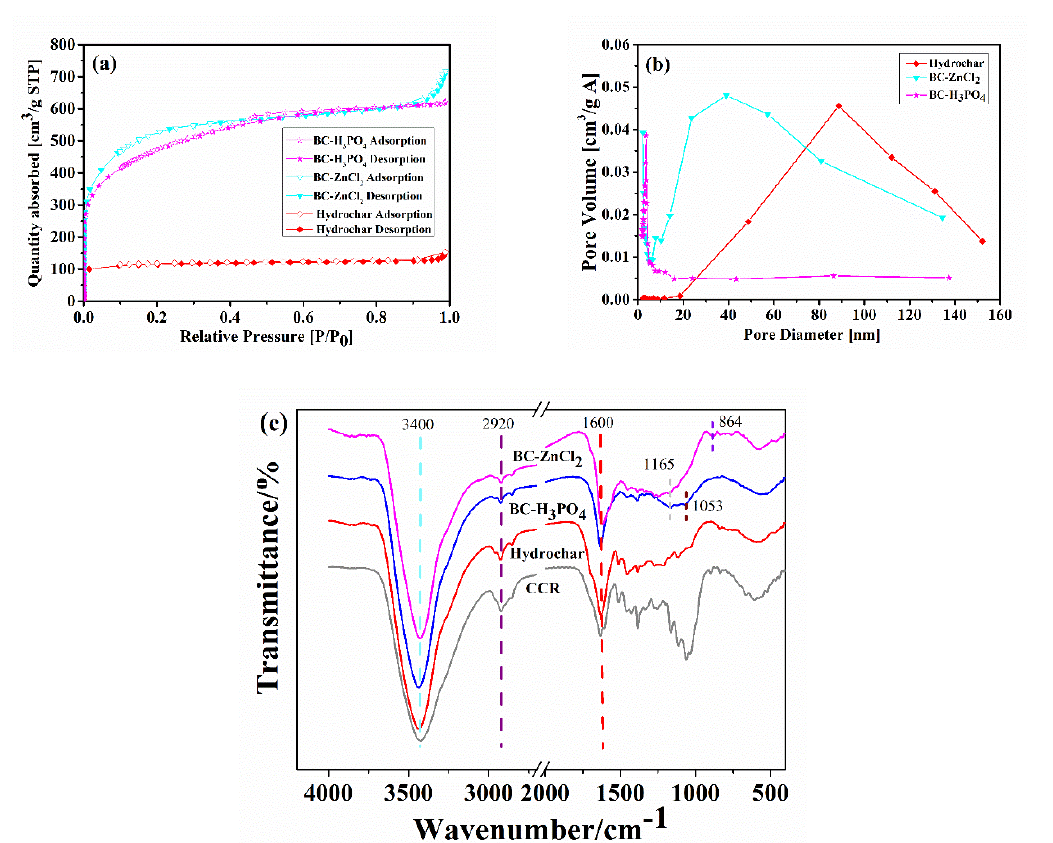
Figure 3. Physicochemical properties of the Biochars. ( a ) Nitrogen adsorption and desorption isotherms of Hydrochar, BC-H 3 PO 4 and BC-ZnCl 2 at 98 K; ( b ) Pore size distribution of Hydrochar, BC-H 3 PO 4 and BC-ZnCl 2 ; ( c ) FT-IR spectra of CCR, Hydrochar, BC-H 3 PO 4 and BC-ZnCl 2 .